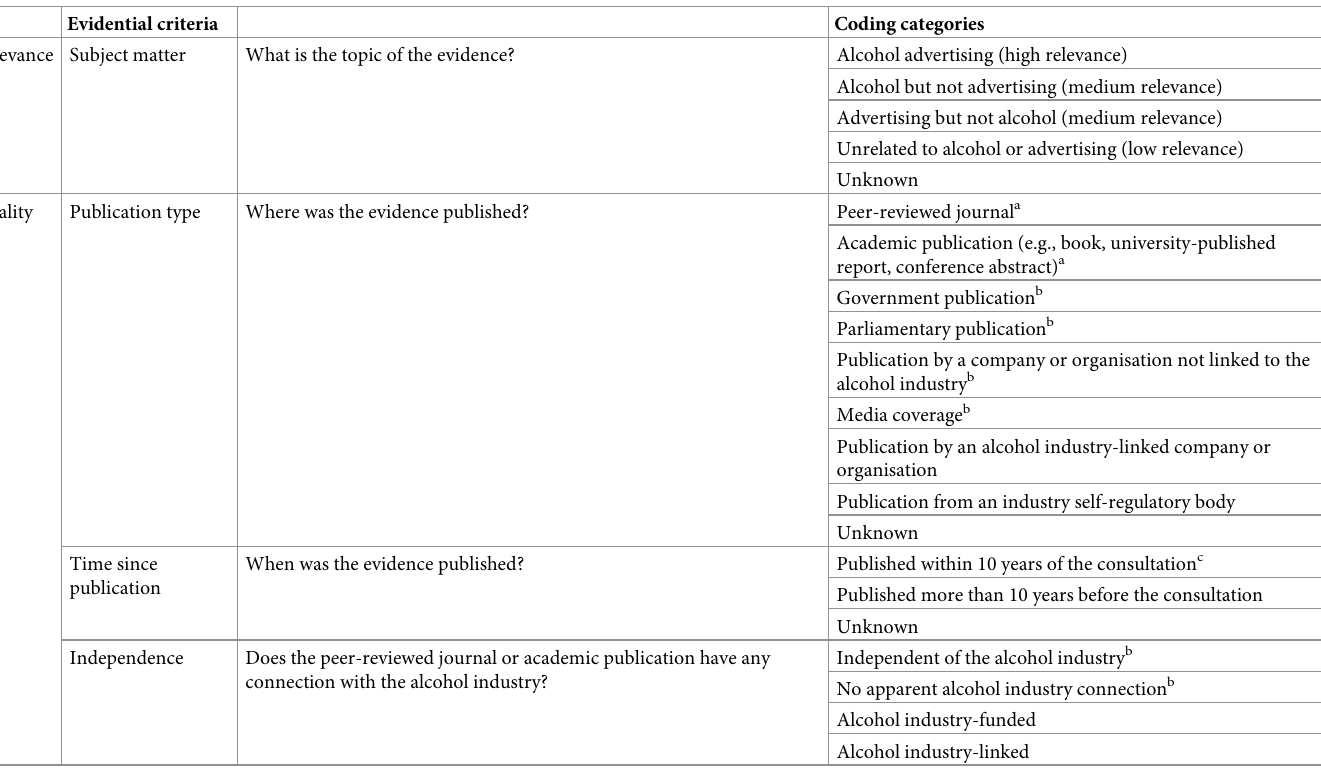
Table 1. Coding framework for classifying